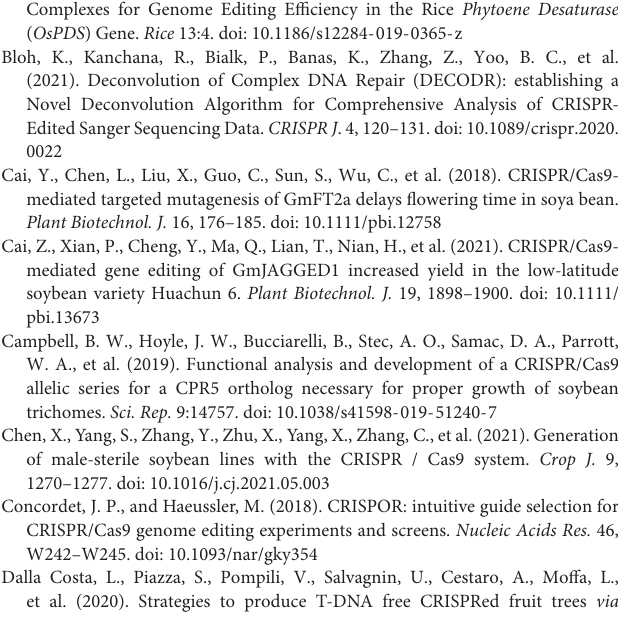
Supplementary Figure 1 | Agarose gel photographs of PCR amplicons during targeted deep and Sanger sequencing. (A,B) Gel images of first (A) and second (B) rounds of multiplex nested PCR products for targeted deep sequencing using primers listed in Supplementary Table 2 . (C) Gel images of PCR amplicons for Sanger sequencing. Lanes M, DNA ladders; T1–T5, Protoplast transformants; C, untransformed wild type (control); T, transformed with RNPs. The expected size of PCR fragments is indicated with red